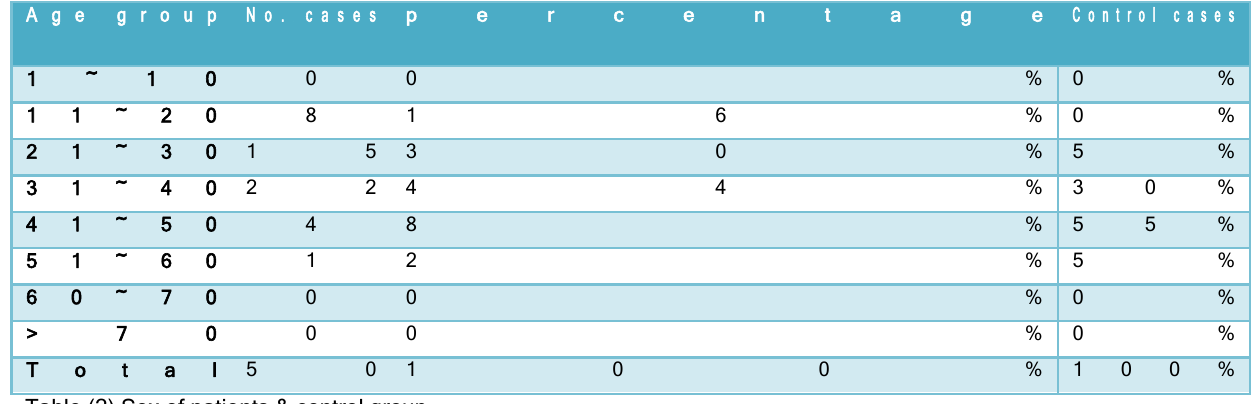
Table (2) Sex of patients & control